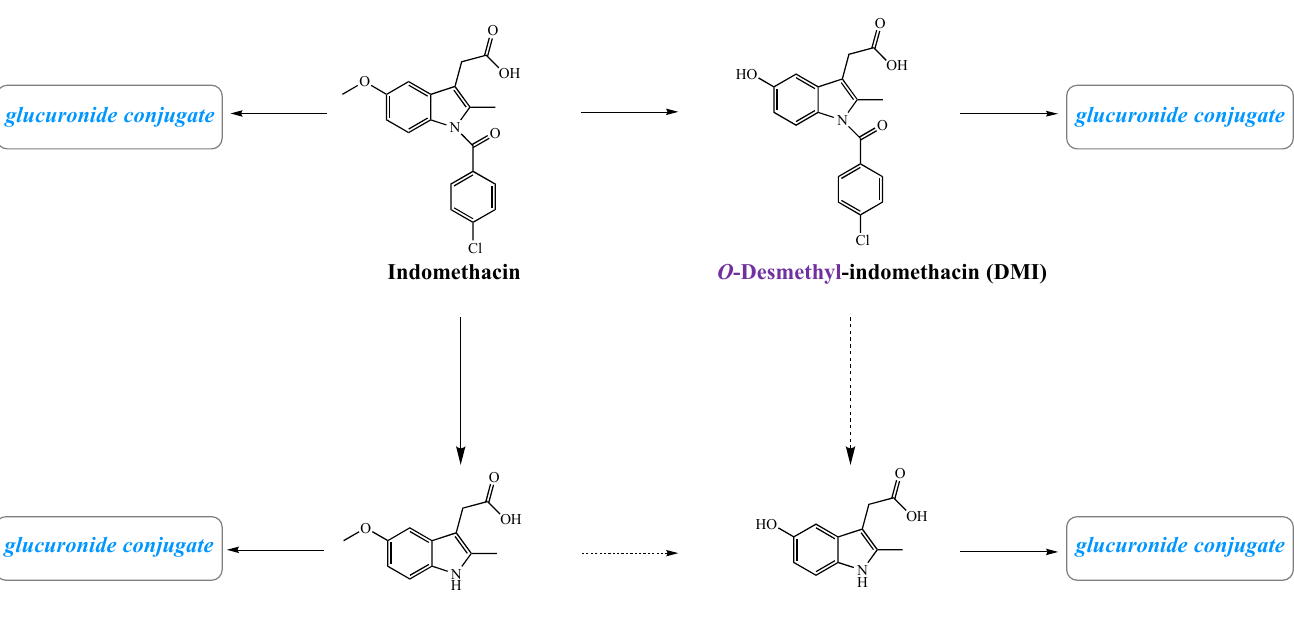
Figure 2. Metabolism of indomethacin in human.